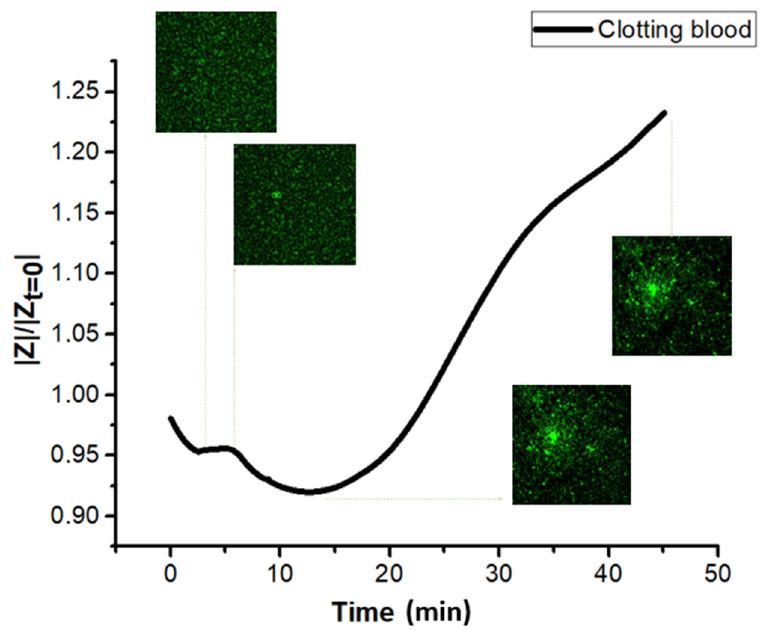
Figure 6. ( a – f ) Detail of a fibrin branch from its appearance at different moments of the contraction. In each frame, the length of fibrin was measured in pixels using ImageJ ® software.